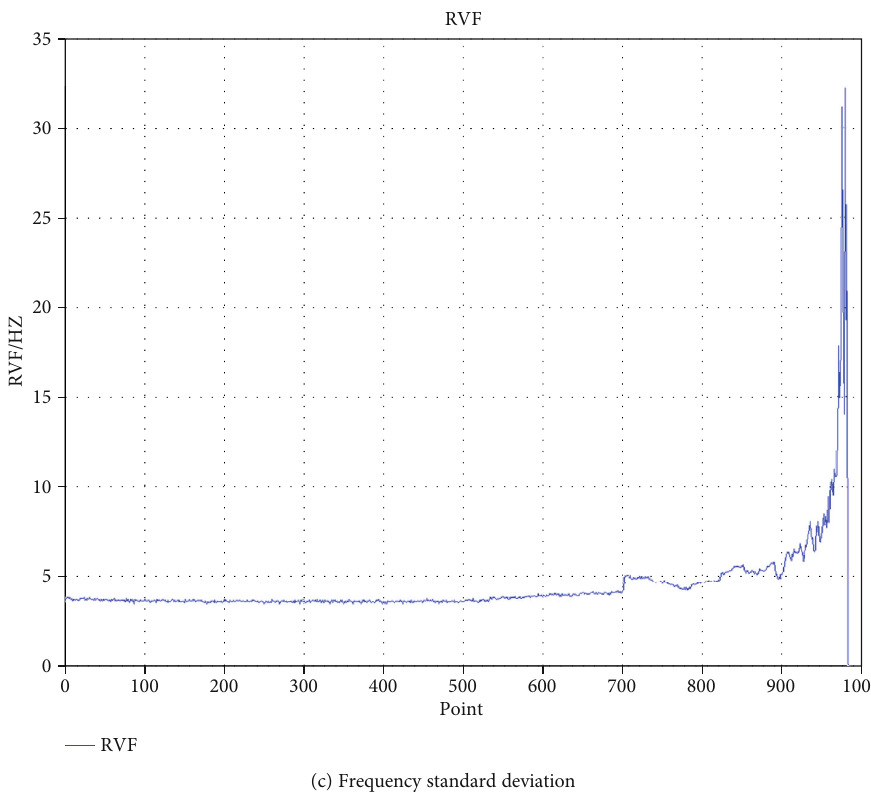
Figure 5: Calculations of center of gravity frequency, frequency root mean square, and frequency standard